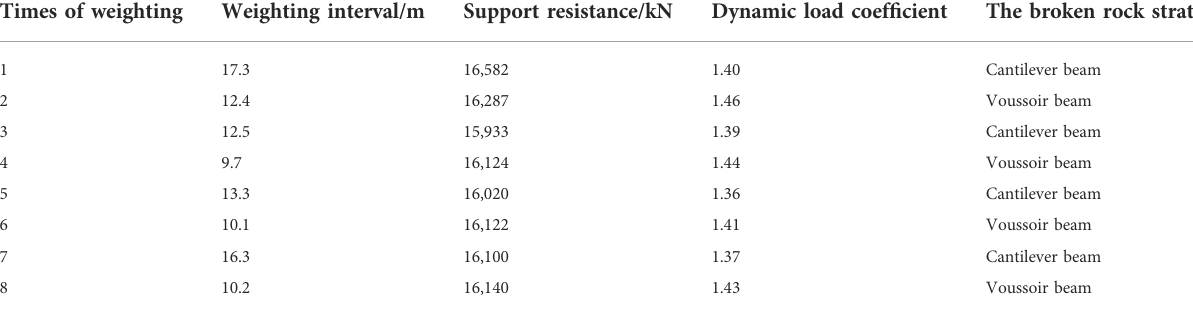
TABLE 6 The weighing characteristic of no.75 support in 22,317 working face. Times of